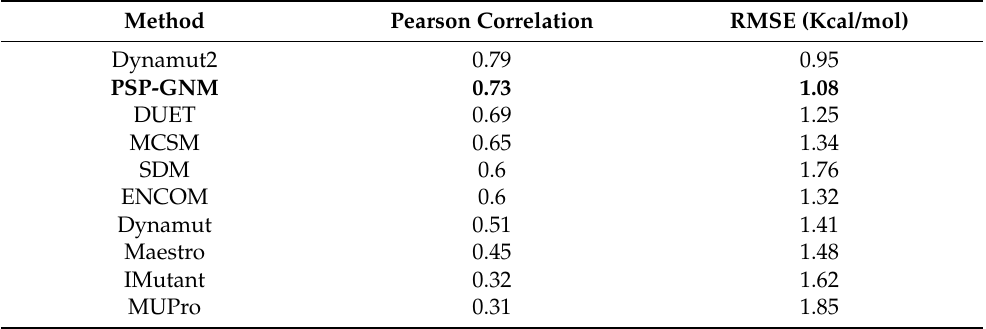
Table 6. Performance on the S611 dataset for a subset of 152 mutations with a PSP-GNM-calculated ∆∆ G and with experimental temperatures ranging from 24 ◦ C to 26 ◦ C and pH ranging from 6.8 to 7.2. The 152 mutations had at least one contact broken, both in the wildtype and mutant forms, for the residue at the mutation position when simulating unfolding with PSP-GNM. The performance for PSP-GNM is shown in bold. Method Pearson Correlation RMSE (Kcal/mol) Dynamut2